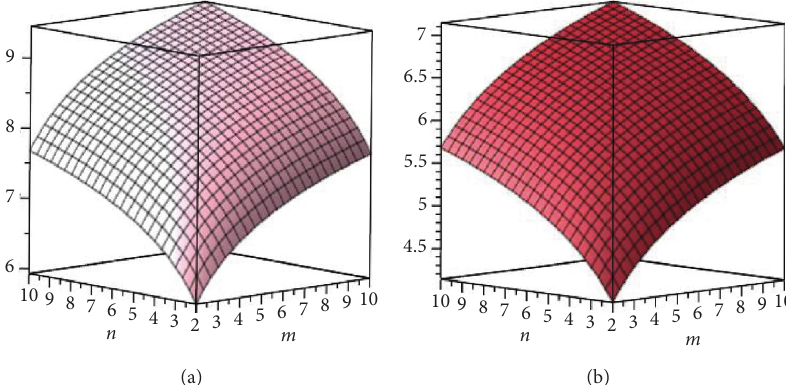
Figure 18: (a) The augmented Zagreb entropy; (b) the Balaban entropy.